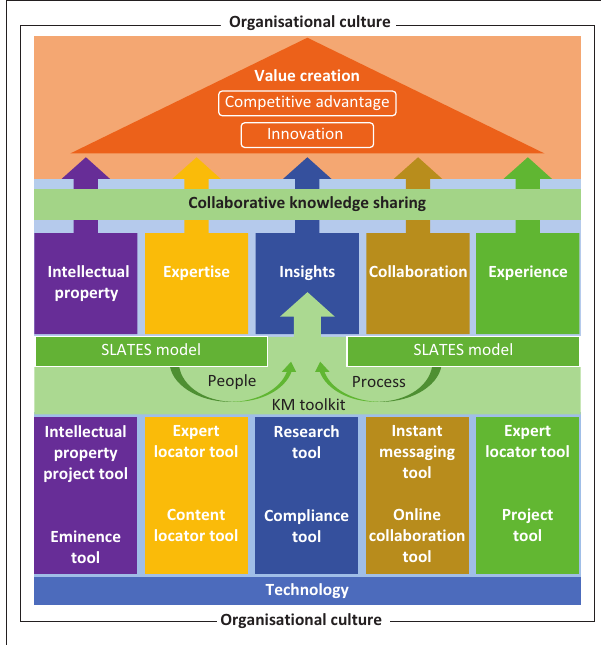
FIGURE 1: Conceptualisation of knowledge management toolkit for value creation framework at the